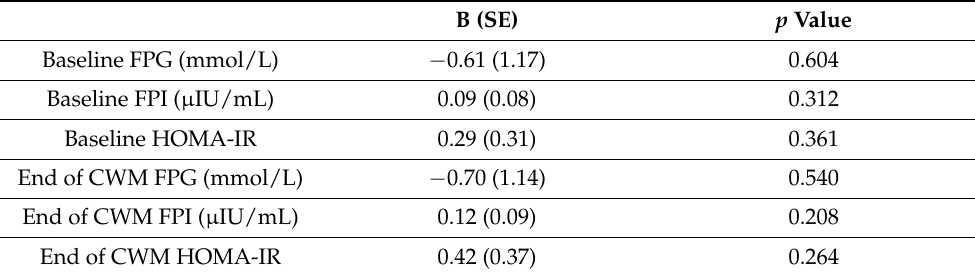
Table 2. Results of linear regression analysis with weight regain (kg) as the dependent variable and glucose homeostasis parameters as the independent variables ( n = 50).